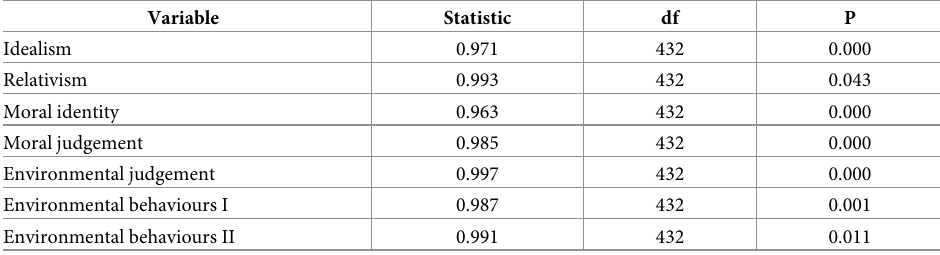
Table 2. Shapiro-Wilk test results for normality